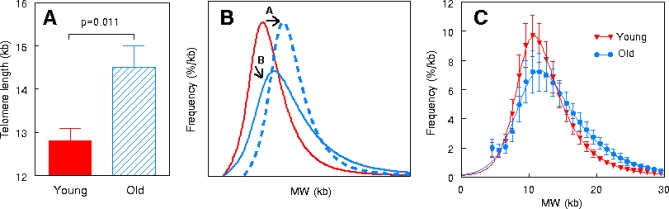
TRFL in Sperm from Young and Older Donors(A) Means of TRFLs in sperm of young and older donors.(B) Two hypothetical scenarios for TRFL distributions in sperm from young and older donors. Scenario A depicts a uniform shift in the TRFL distribution towards longer telomeres in sperm of older men (interrupted blue line) from that of younger men (red line). Scenario B depicts a reconfiguration of the distribution, so that shorter telomeres are disproportionably “under-represented,” while longer telomeres are “over-represented.”(C) Frequency distributions of TRFLs in sperm from young and older donors. For (C), data were fitted to a 4-parameter logistic dose response distribution curves, y = a0+a1/[1+(x/a2)a3], using TableCurve 2D software (SYSTAT Software).